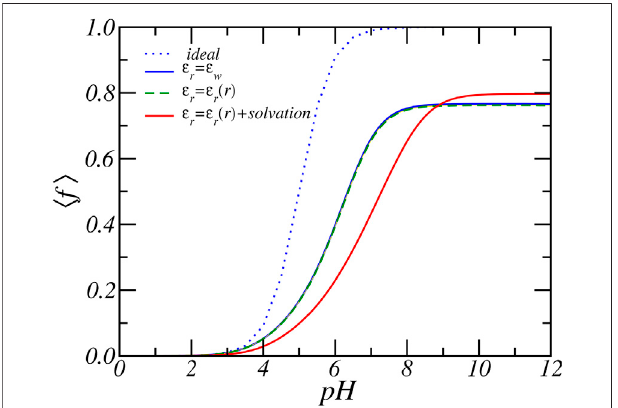
FIGURE 6 | The radial cylindrical number density distribution of free Rb + ions (solid lines) and bound Rb + ions (dashed lines). The different lines correspond to different carboxylate-Rb dissociation free energies. The reservoir has a pH of 7.4 and a RbCl concentration of [RbCl] = 50 mM .